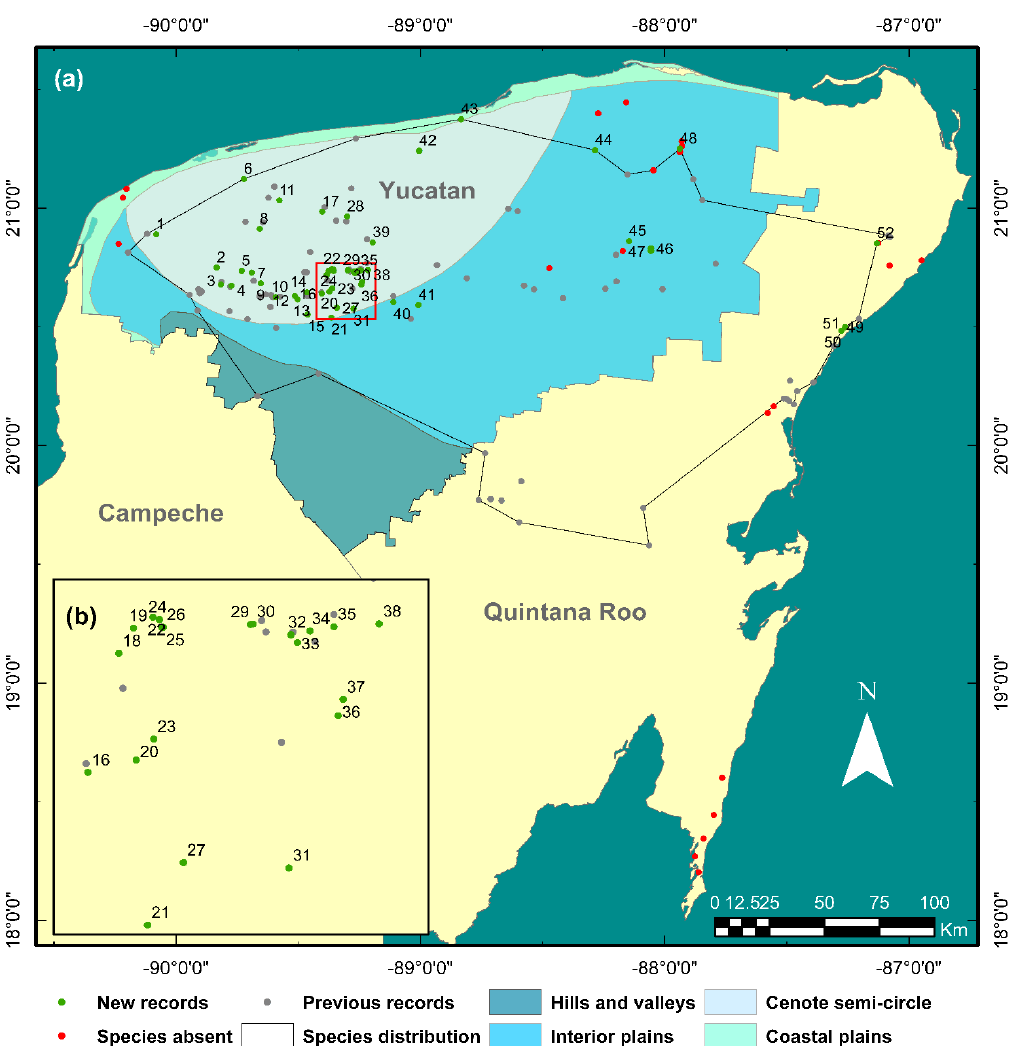
Figure 6. ( a ) New records for A. cenotensis (green dots), locations where the species was not found (red dots, named in Figure 7), previous records (gray dots), and current species distribution (polygon) extracted from total available data. ( b ) Close-up of stacked new records (in red square). Hydrogeological zones are also shown for the state of Yucatan. Location names are presented along with the municipality where it is found (between parentheses) for each state (italics). Yucatán: (1) Xelactún